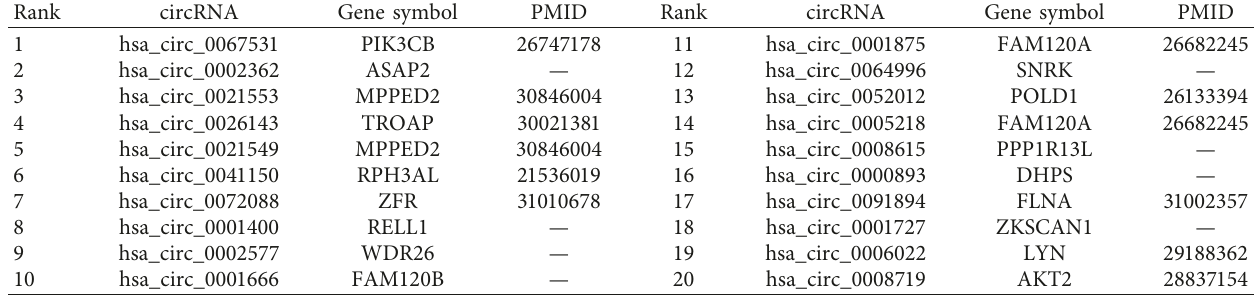
Table 2: Literature validation of the top 20 results.